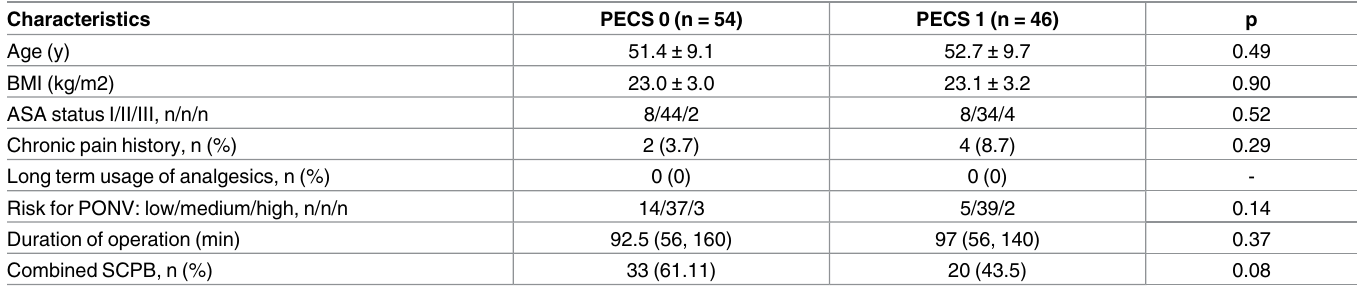
Table 1. Patient demographics and clinical characteristics shown according to treatment arm.